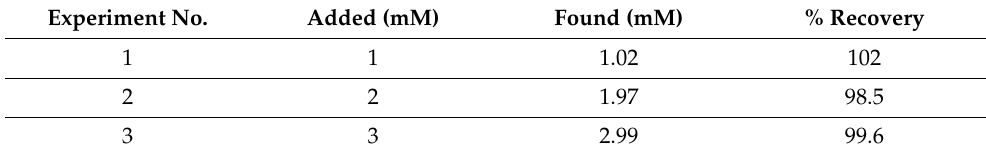
Table 2. Percent recovery response of cholesterol oxidase-immobilized Co 3 O 4 nanocrystals. Experiment No.